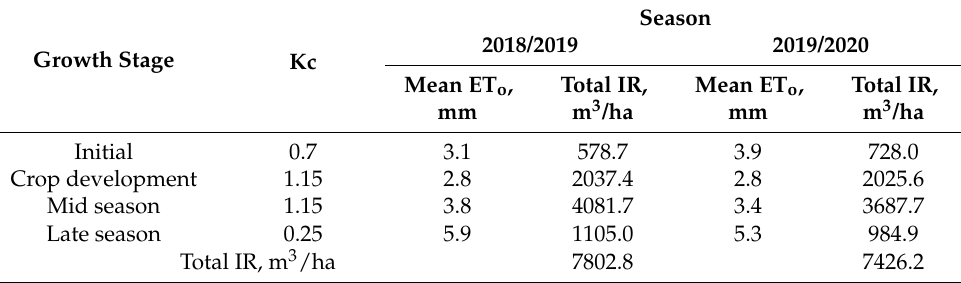
Table 1. Details of irrigation requirements of two consecutive seasons (2018/2019 and 2019/2020) for wheat based on the reference evapotranspiration calculated by FAO 56 Penman–Monteith equation. The irrigation system efficiency of 75% is considered in the